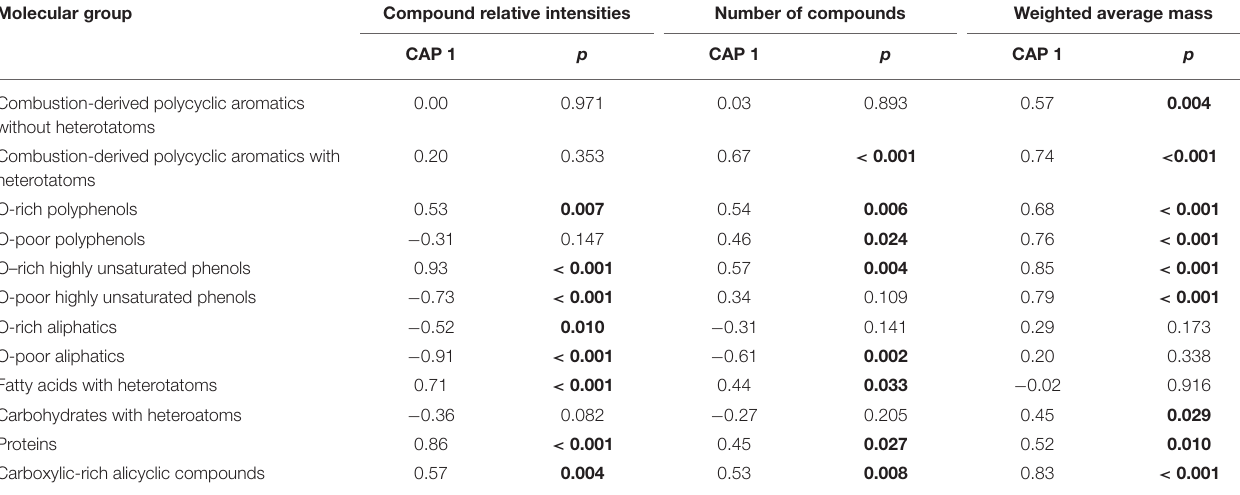
TABLE 2 | Spearman correlations of molecular group variables derived from FT-ICR-MS (the relative intensity, number and weighted average mass of the compounds in each molecular group) with the first axis of the canonical analysis of principal coordinates (CAP) of DOM molecular composition (relative intensities of the 3,900 compounds) using the current riparian forest, as sole explanatory